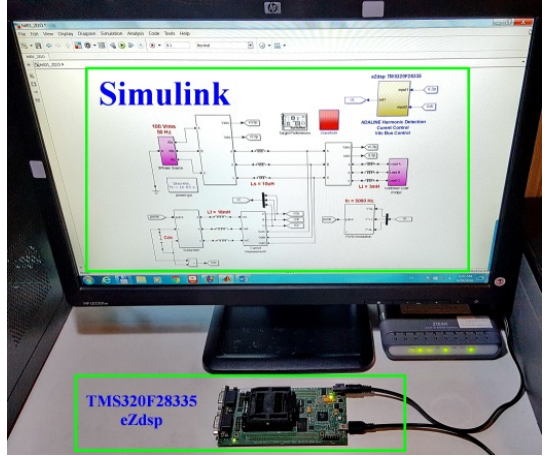
Figure 7. The HIL simulation.